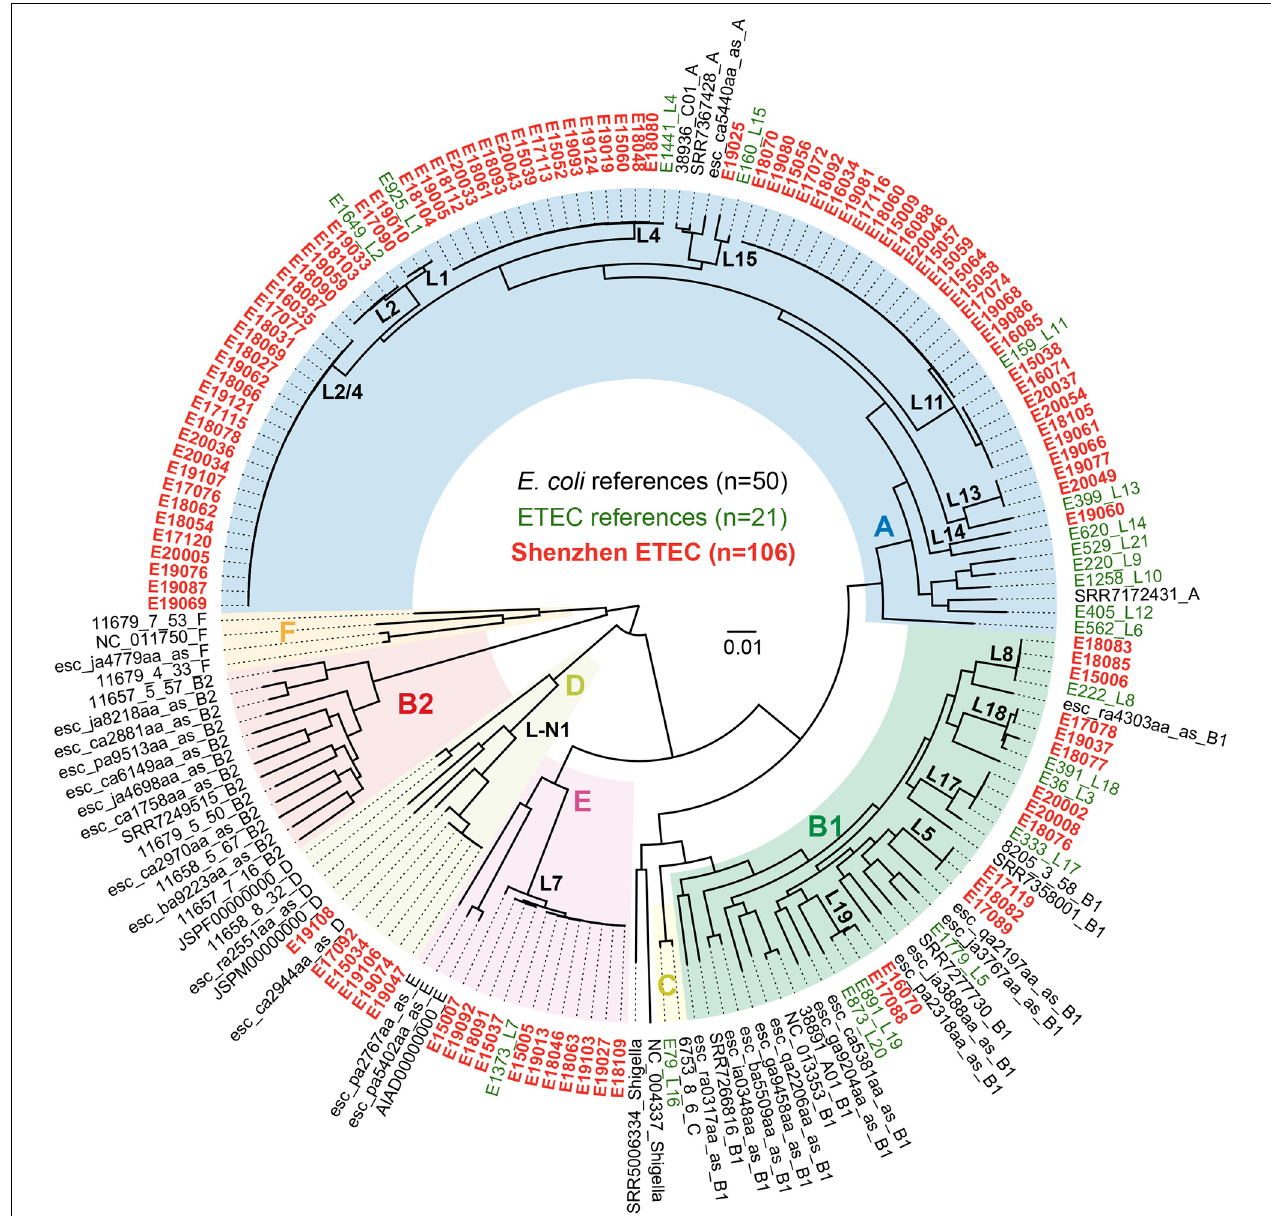
FIGURE 1 | Maximum-likelihood phylogenetic tree of 177 E. coli and ETEC isolates. Colors of the tree tip labels indicated the source of isolates, black for representative E. coli isolates from the largest 50 E. coli lineages, green for representative isolates from 21 global ETEC lineages, and red for 106 Shenzhen ETEC isolates. Background colors of the phylogenetic branches indicated the E. coli